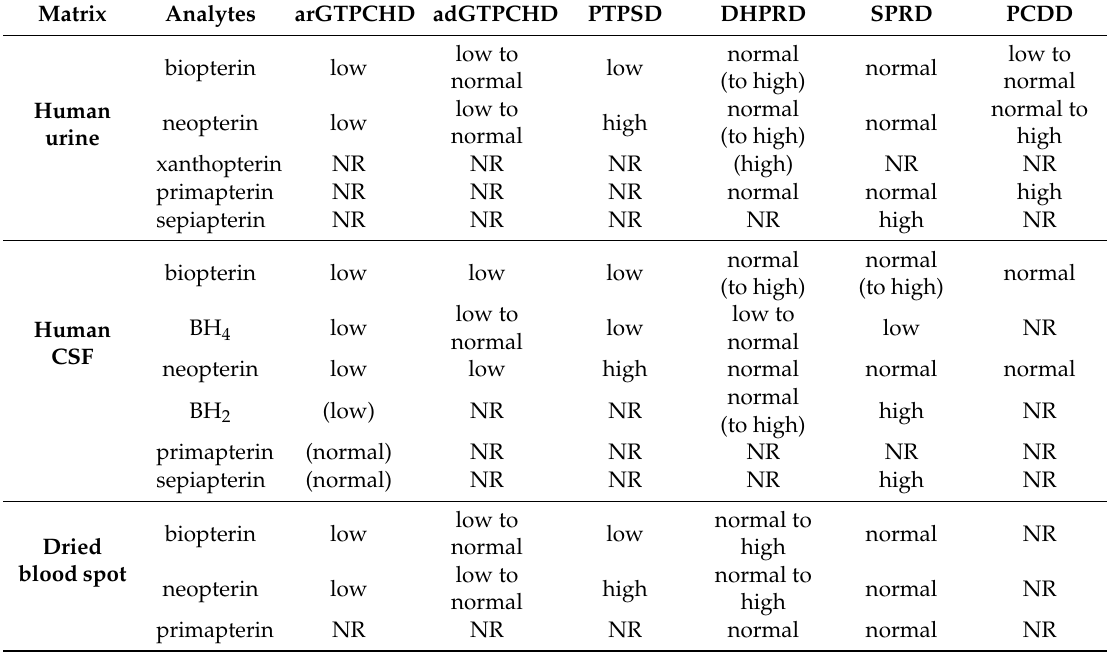
Table 6. Pterin profiles in di ff erent body fluids in BH 4